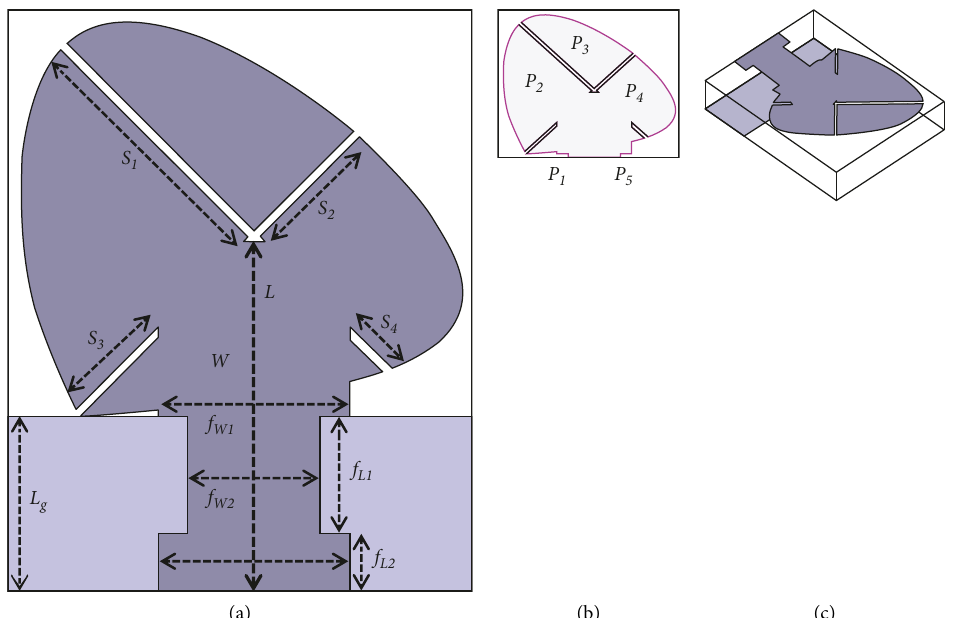
Figure 1: (a) Geometrical layout of the proposed single element. (b) Outline of the titled patch. (c) Perspective view of the proposed single